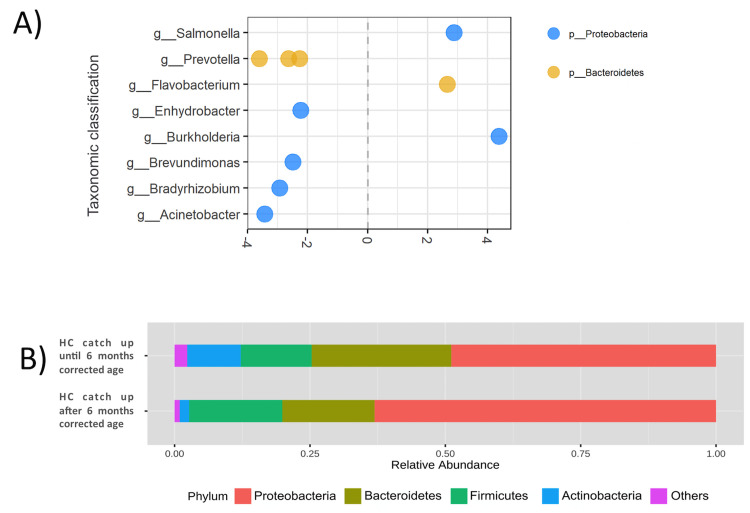
Differential abundance analysis according to head circumference catch up.Each dot represents an individual OTU, organized by their Genus. (A) Differential abundance analysis according to early or late HC catch up. Data plotted as log2 fold change; OTUs to the right of the zero line were more abundant in HC catch up until 6 months corrected age group, and OTUs to the left of the zero line were more abundant in HC catch up after 6 months corrected age group. (B) Difference for microbial composition between infants with early HC catch up growth (up to 6 months) and late HC catch up growth (after 6 months); HC: head circumference.